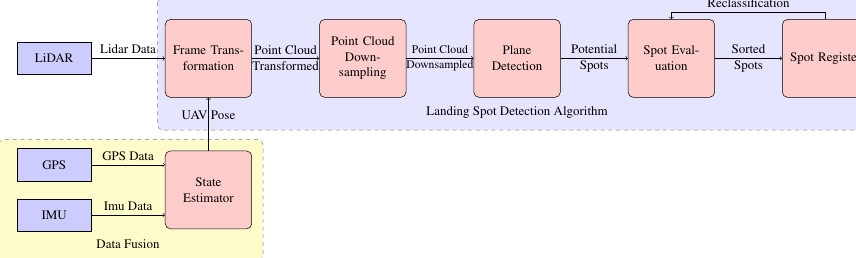
Figure 3. High-level software pipeline